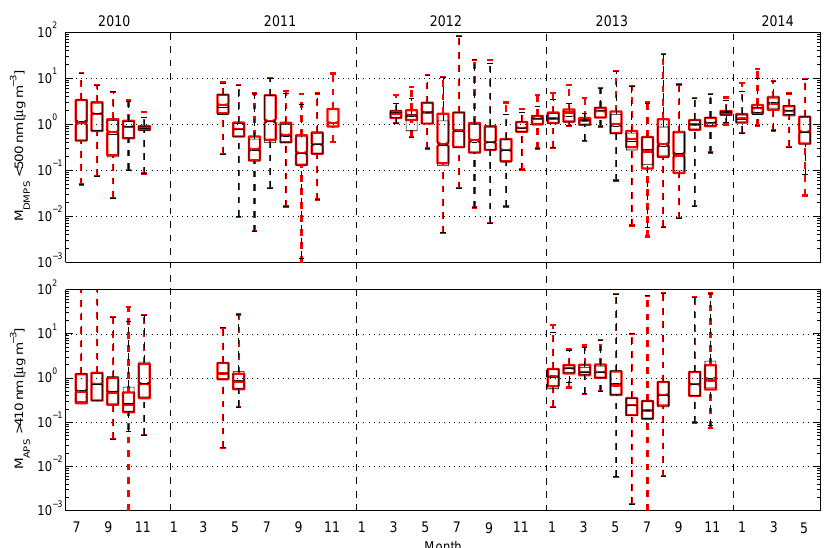
Figure 4. Temporal variability in aerosol total (7–500nm) and coarse-mode ( > 410nm) mass concentration in top and bottom panel, re- spectively. Red bars show quartiles for each month of data available, and whiskers show the extremes. Black bars are calculated equally but excluding data measured when wind speed was < 2ms − 1 . Dotted black lines mark the boundary between years.